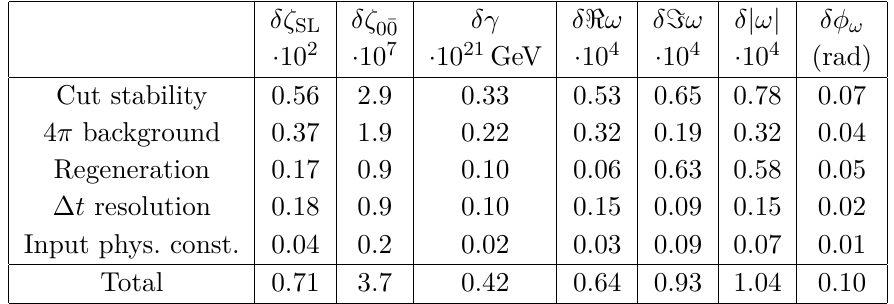
Table 1 . Systematic uncertainties on all decoherence and CPT -violating parameters.